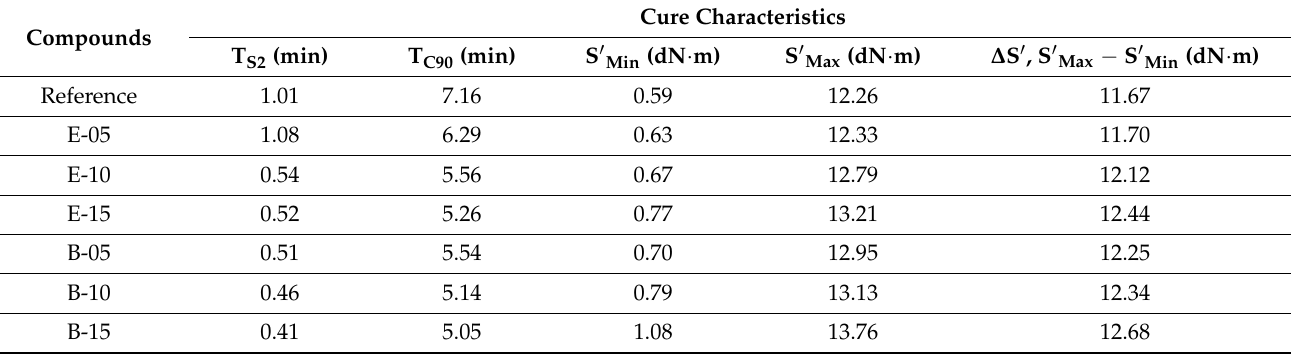
Cure Characteristics